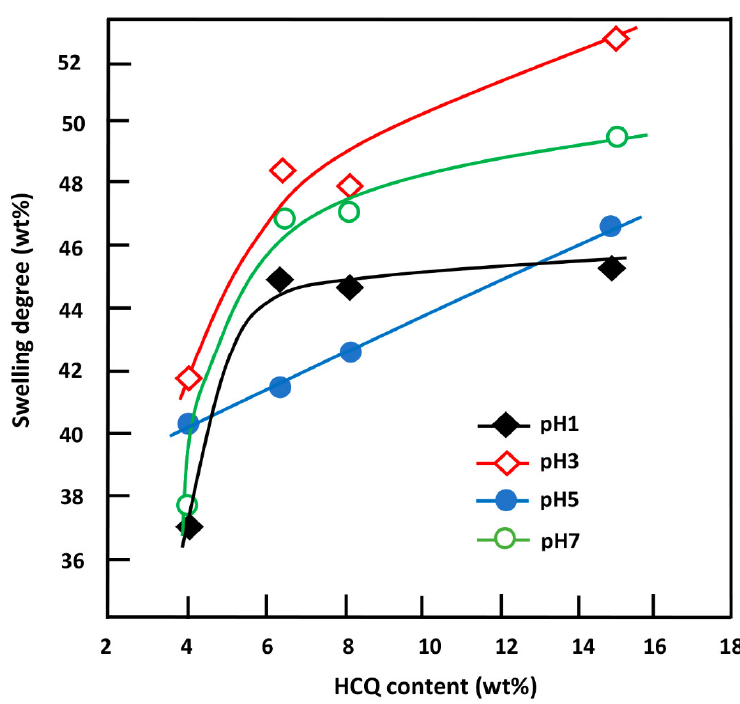
Figure 12. Variation of the swelling capacity of CQMA-co-HEMA systems in different pH media versus the HCQ content.